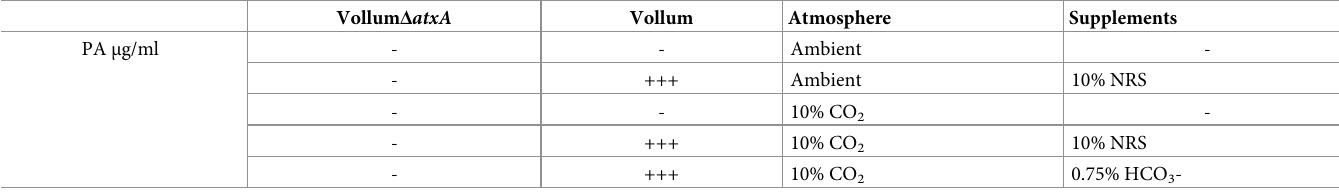
Table 2. Protective antigen secretion ( μ g/ml) of Vollum or Vollum Δ atxA under different growth